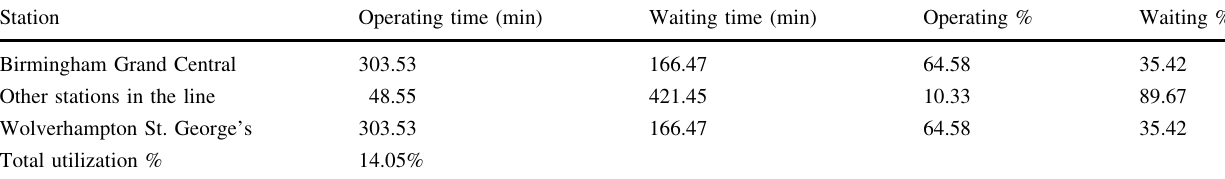
Table 6 Operating and waiting times of the system during off-peak hours in clockwise direction